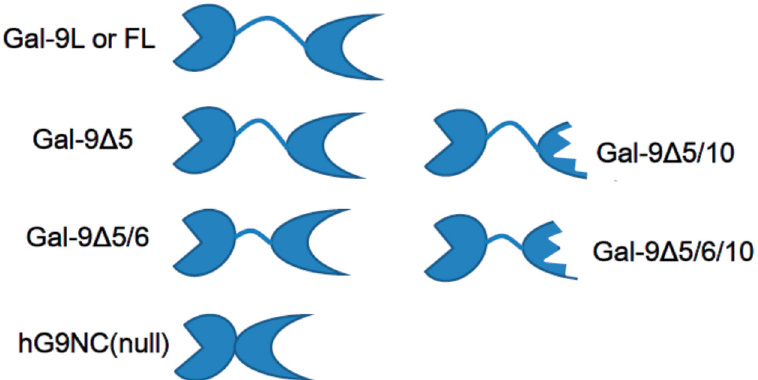
Figure 2. Structure of galectin-9 isoforms and recombinant galectin-9 lacking a linker peptide, human recombinant galectin-9 (hG9NC) (null). Galectin-9 has two distinct carbohydrate recognition domains connected by a linker peptide with variable lengths. Two isoforms lacking exon 10 transcripts are not equipped with the C-terminal carbohydrate recognition domain.